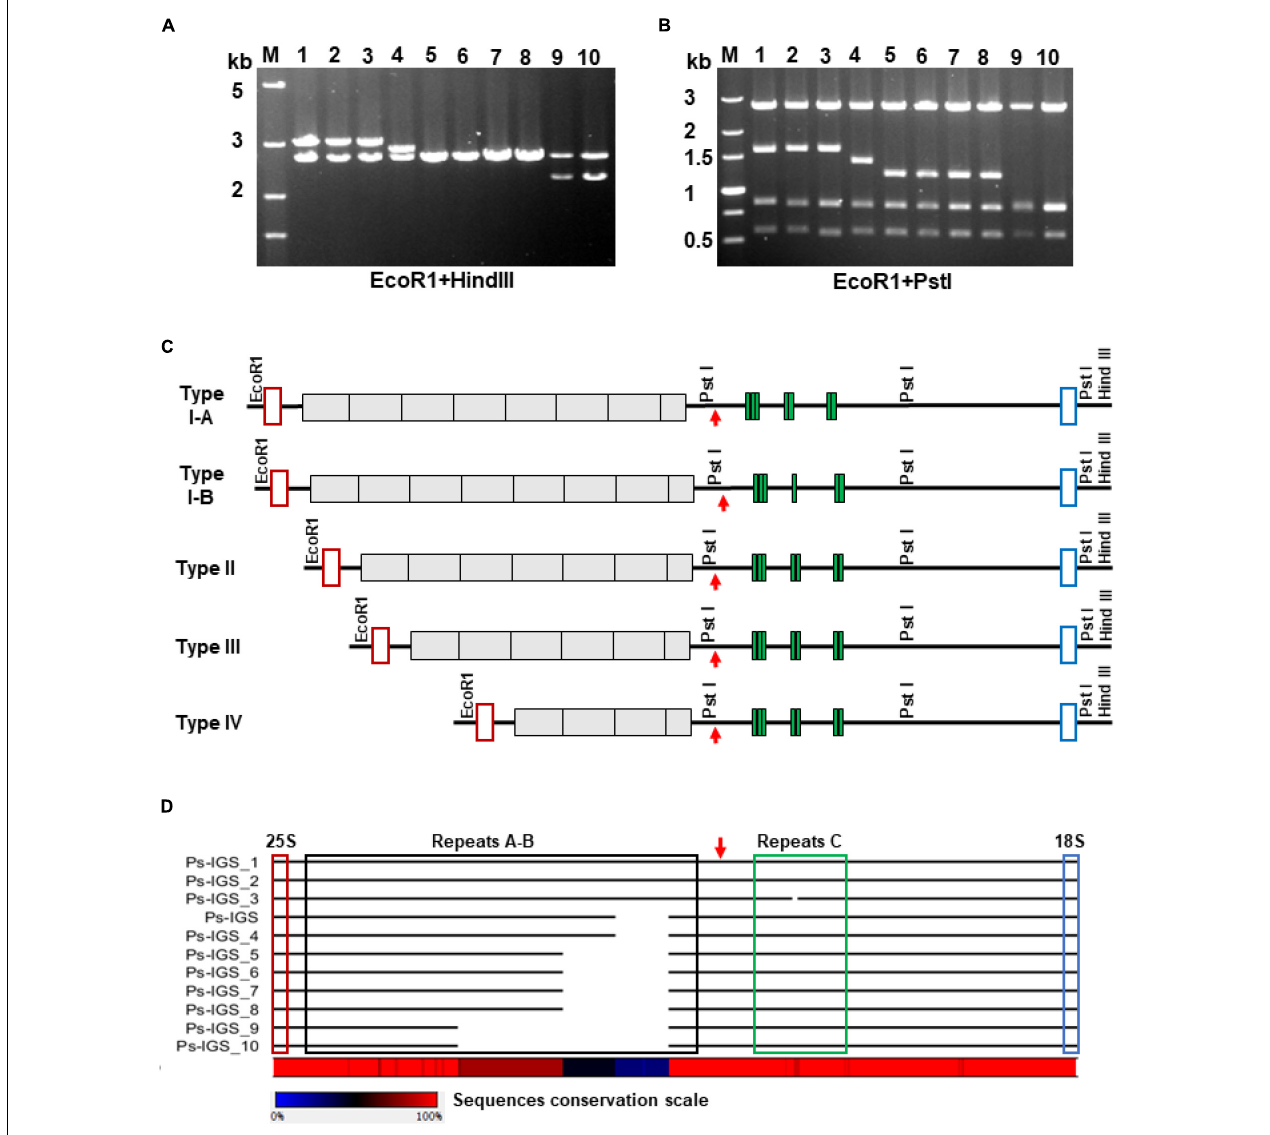
FIGURE 3 | Polymorphism of the P. stratiotes 35S rDNA repeat units, as revealed by analysis of IGS sequences in 10 clones containing PCR-amplified fragments. (A,B) Length variation of the cloned IGSs, as revealed by analyzing restriction fragment polymorphisms produced by digesting plasmid DNA with the restriction enzymes Eco RI plus Hin dIII (A) and Eco RI plus Pst I (B) and visualized by agarose gel electrophoresis. M—DNA fragments of molecular weight marker DL5000 (Takara) with their length in kilobases on the left site of the gel; numbers 1–10 above the gel images correspond to DNA clones Ps-IGS_1 to Ps-IGS_10. (C) Molecular structures of rDNA fragments depicted in A and B, based on full-length nucleotide sequences of the clones. The 10 clones were divided into four major groups based on the sequencing results: Type I–IV, depending on number of repeats in A-B and C. Clones Ps-IGS_1 and Ps-IGS_2 represent Type IA; Ps-IGS_3 represents Type IB; Ps-IGS_4 represents Type II; Ps-IGS_5, Ps-IGS_6, Ps-IGS_7, and Ps-IGS_8 represent Type III; Ps-IGS_9 and Ps-IGS_10 represent Type IV. Open red rectangles mark 25S rDNA sequences; gray blocks mark A-B repeats, green blocks mark C-repeats; open blue rectangles mark 18S rDNA sequences; the TIS is marked by a red arrow. (D) Simplified representation of the sequence alignment of the clones; the full nucleotide alignment and the sequences’ accession numbers are shown in Supplementary Figure 4